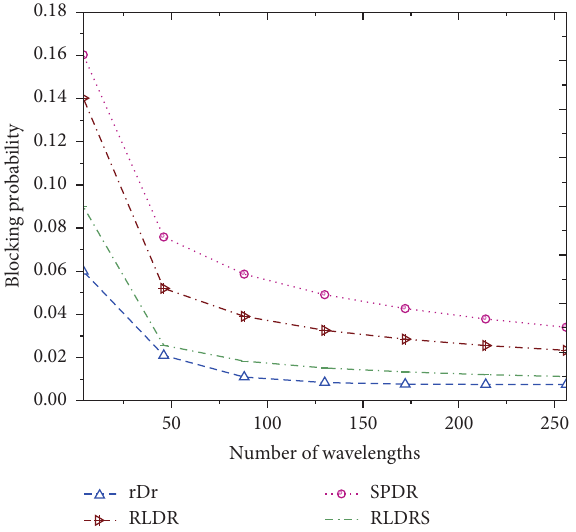
Figure 16: Blocking probabilities as a function of number of